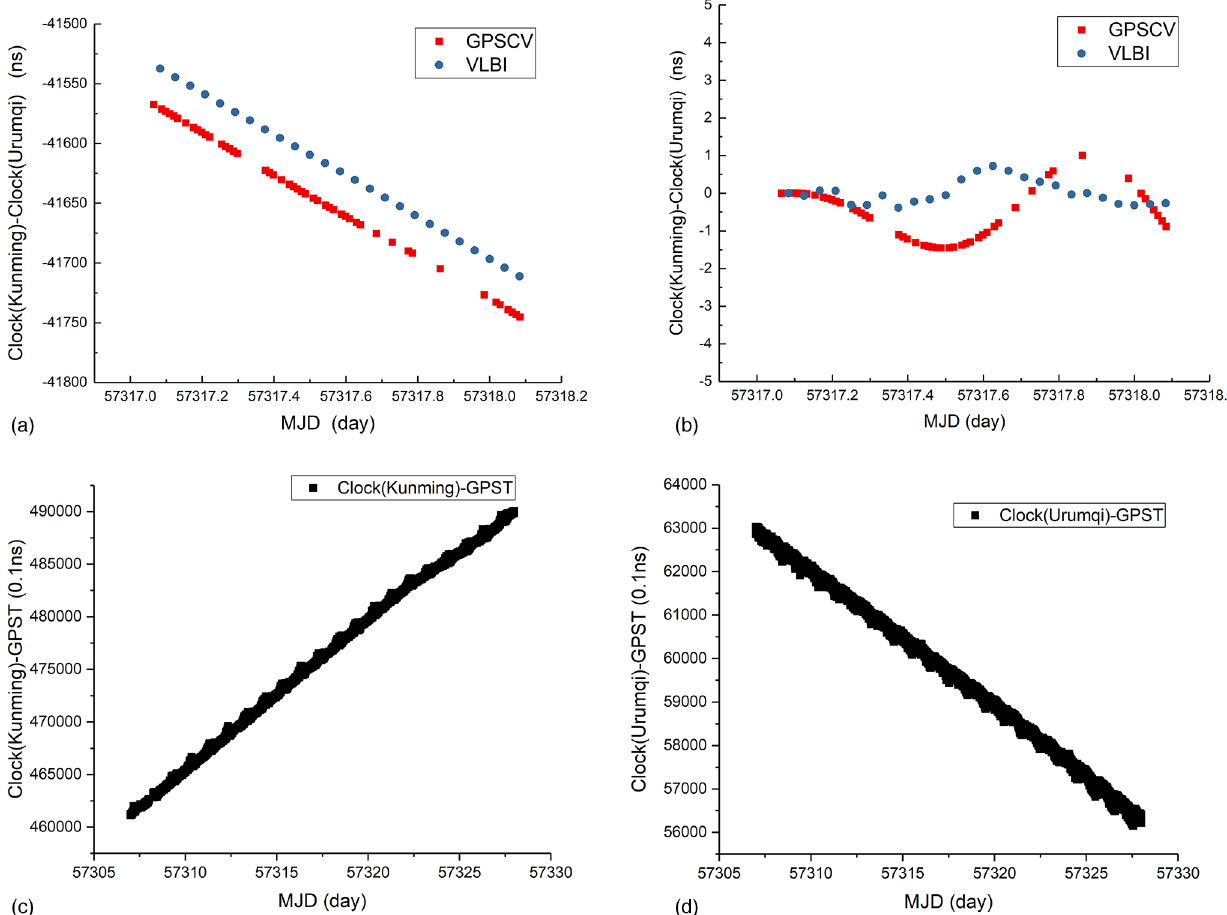
Fig. 4. Clock differences at the Kunming and Urumqi stations in MJD57317. (a) Clock differences calculations based on GPS CV and VLBI respectively. (b) Clock difference series after removing the linear trend. (c) Clock difference series between the Kunming station clock and GPST across 20 days surrounding MJD57317. (d) Clock difference series between the Urumqi station clock and GPST across 20 days surrounding